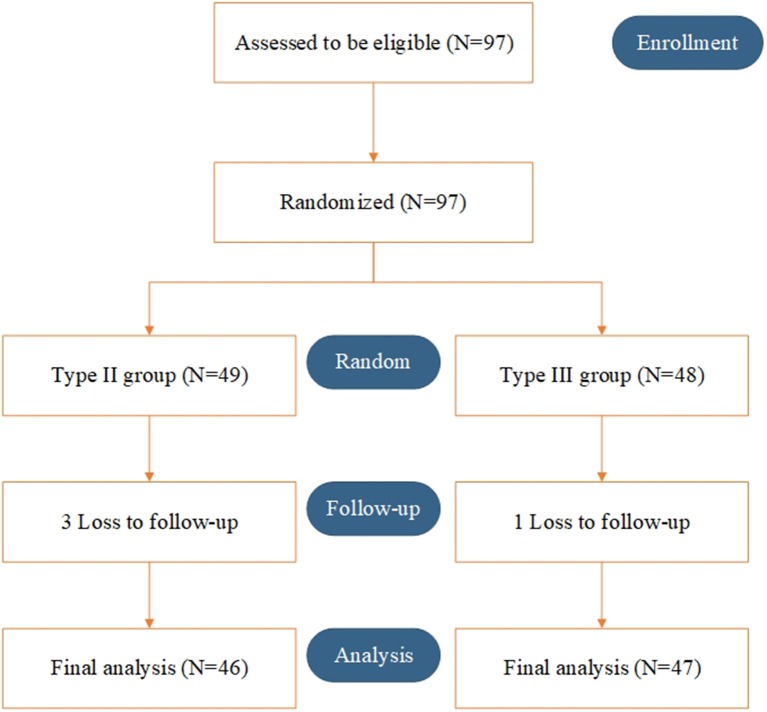
Consort diagram.